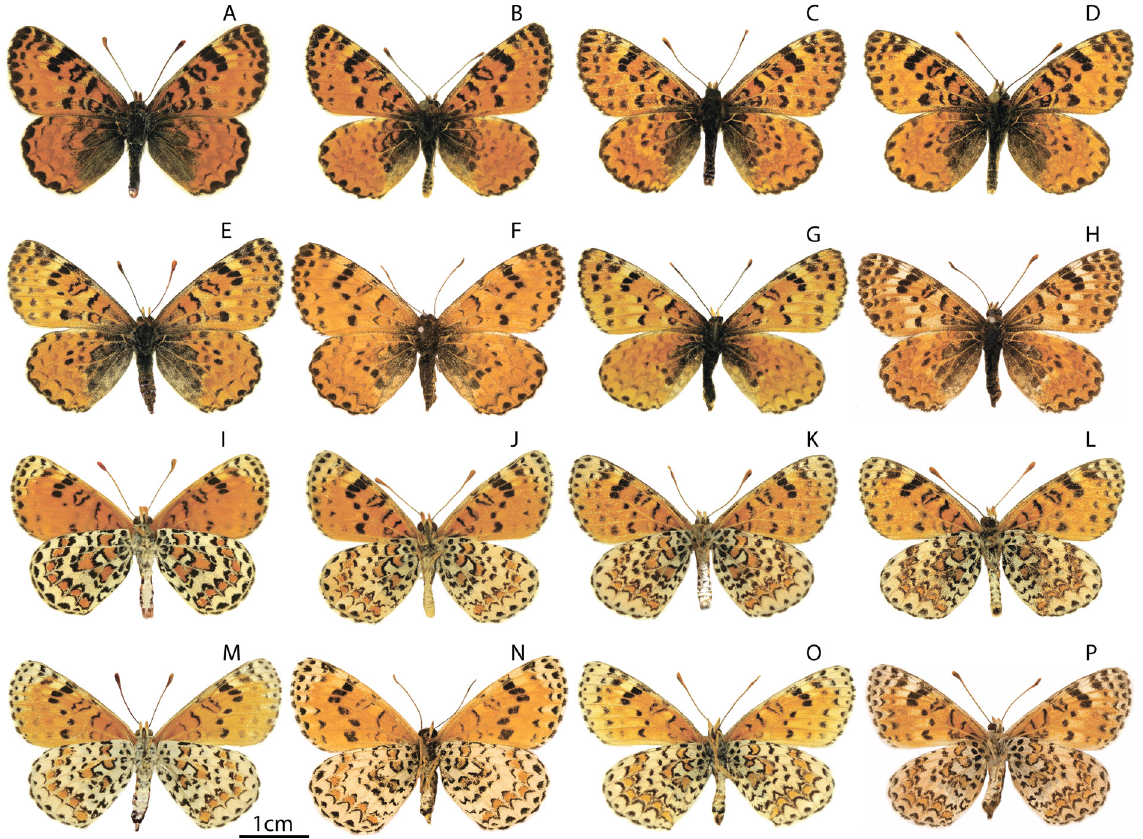
Fig. 2. Adults of Melitaea lutko Evans, 1932 and M. timandra binaluduca subsp. nov. A – H .